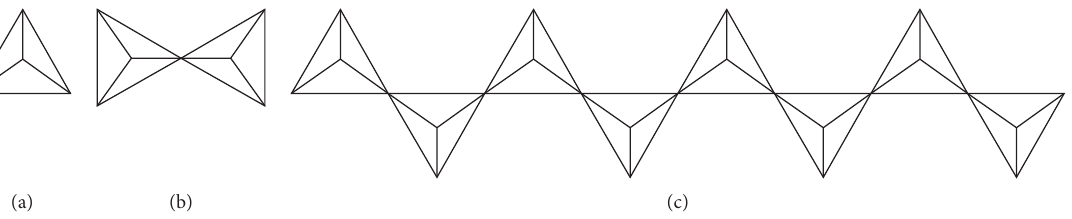
Figure 7: (a) Ortho, (b) pyro, and (c) chain silicates.